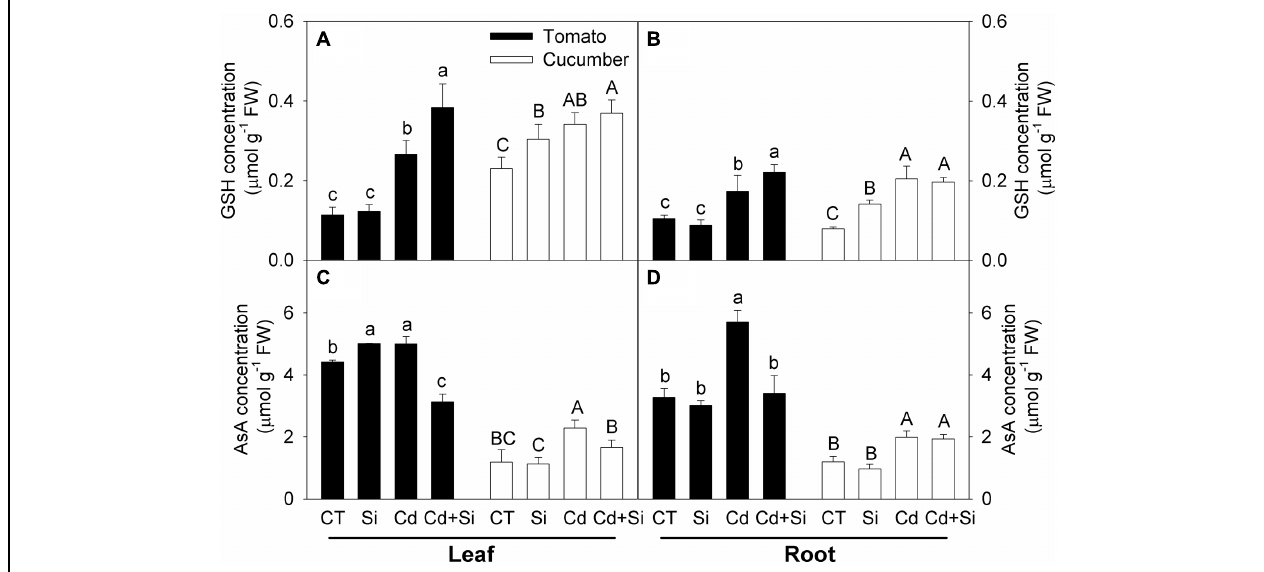
FIGURE 6 | Effects of Si on GSH (A,B) and AsA (C,D) contents in plants under Cd stress. (A) GSH content in leaves; (B) GSH content in roots; (C) AsA content in leaves; (D) AsA content in roots. Bars with different letters mean significant difference at P < 0.05 according to one-way ANOVA (Lower-case and upper-case letters indicate significance for tomato and cucumber,